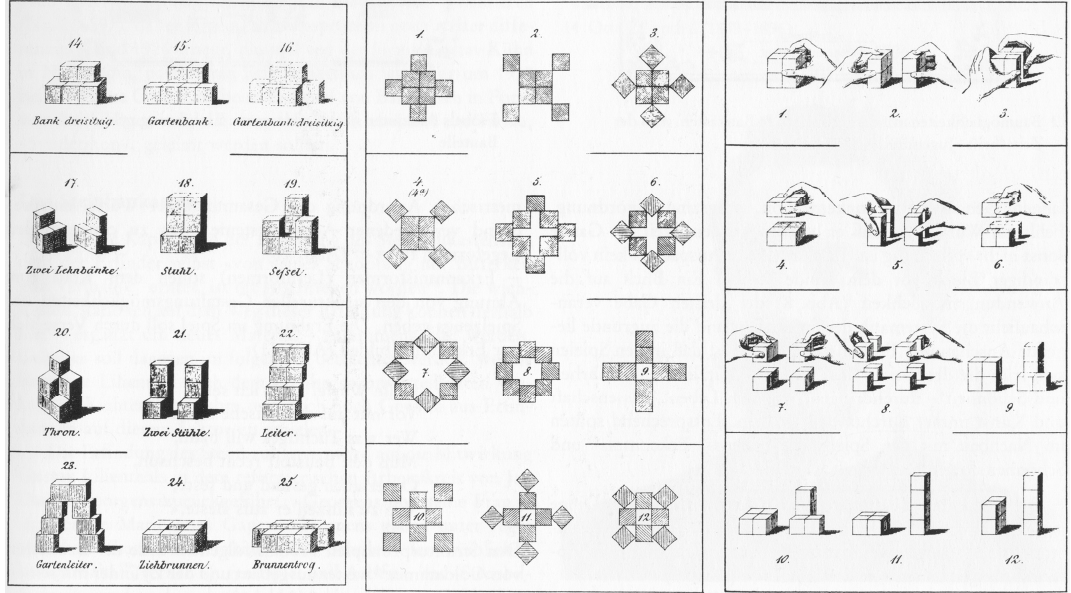
Figure 5. Friedrich Fröbel: Applications of Spielgabe 6: “Lebensformen” (‘life forms’), “Schönheitsformen” (‘beauty forms’) and “Erkenntnisformen” (‘learning forms’)—Drawings published in the journal Jugendlust , 1881.